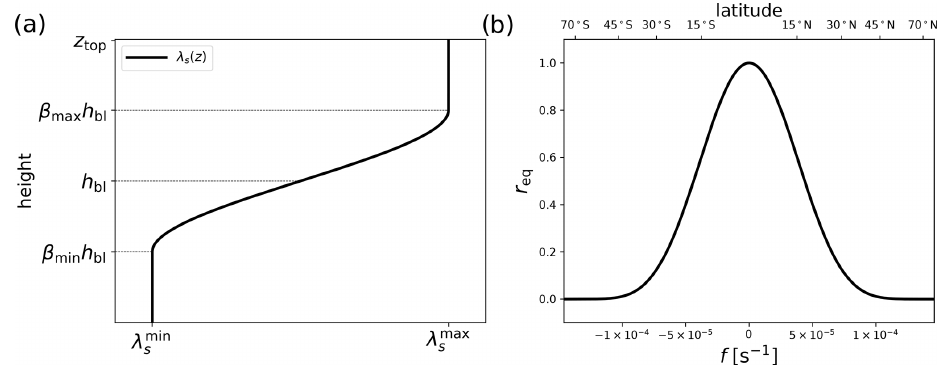
Figure 1. (a) Typical profile of the nudging coefficient λ s (z) with respect to the parameters λ max s ,λ min s ,β min ,β max ,h bl . (b) Equatorial restoring function r eq with respect to the Coriolis frequency f .